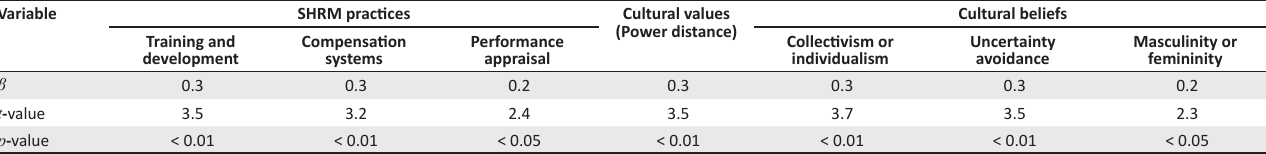
TABLE 4: Regression analysis of factors influencing motivation at work. Variable